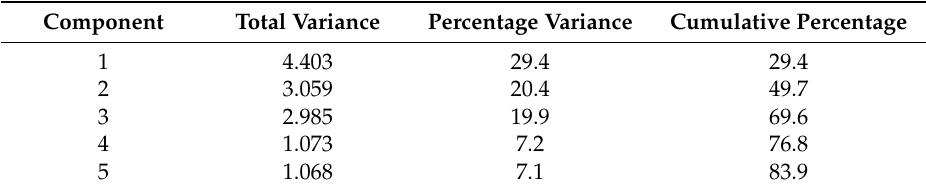
Table 3. Total variance explained by the components generated using factor analysis.